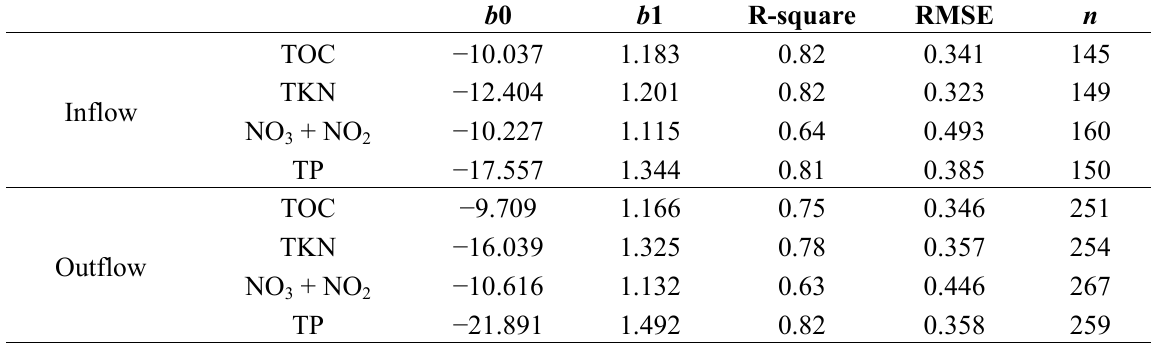
Table 1. Parameter estimates ( b 0 and b 1), root of mean square error (RMSE), and sampling size (n) used for calculating [see Equation (1)] daily mass transport of total organic carbon (TOC), total Kjeldahl nitrogen (TKN), nitrate and nitrite nitrogen (NO + NO ), and total phosphorus 3 2